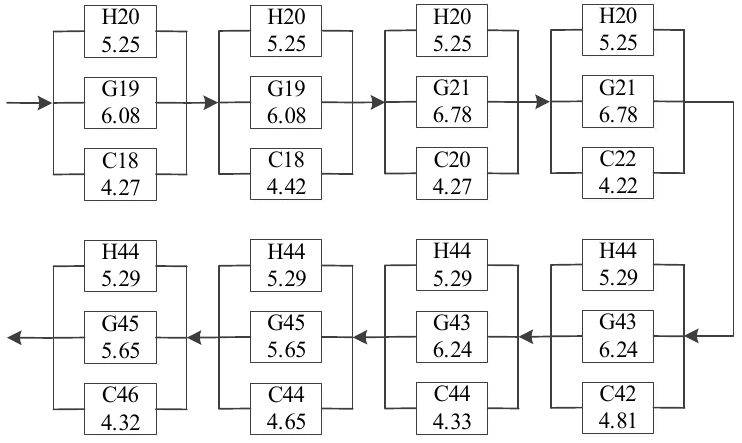
Figure 14. Fault tree of the suspension bridge.